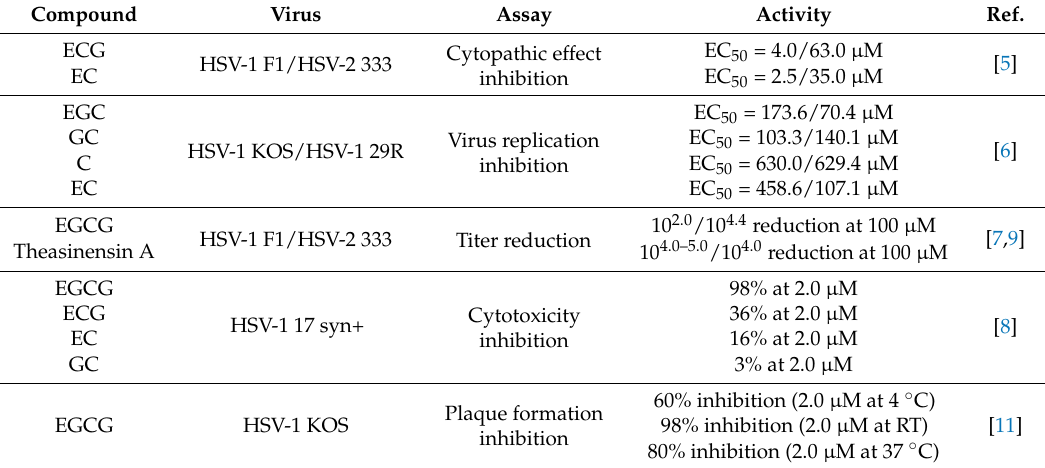
Table 1. Summary of Antiviral Activity of Catechins on Enveloped DNA